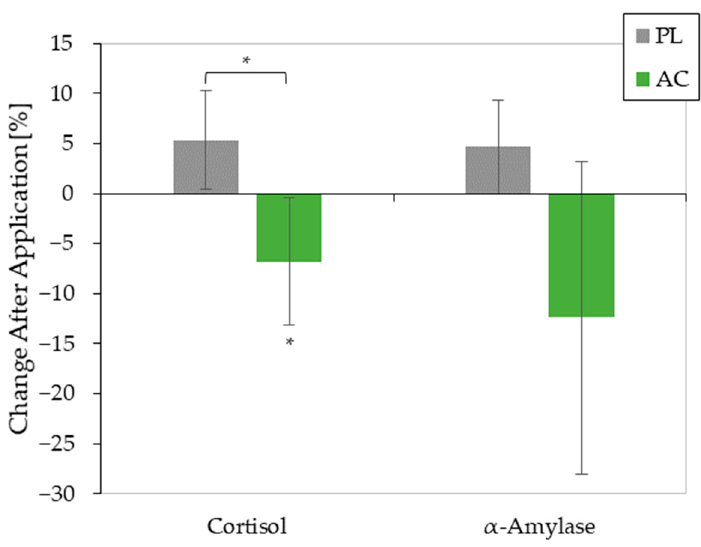
Figure 4. Change of salivary concentration of cortisol and α -amylase when compared after vs. before product application of the samples placebo (PL) and active compound (AC) (mean ± SD). Note: * Significance with p <